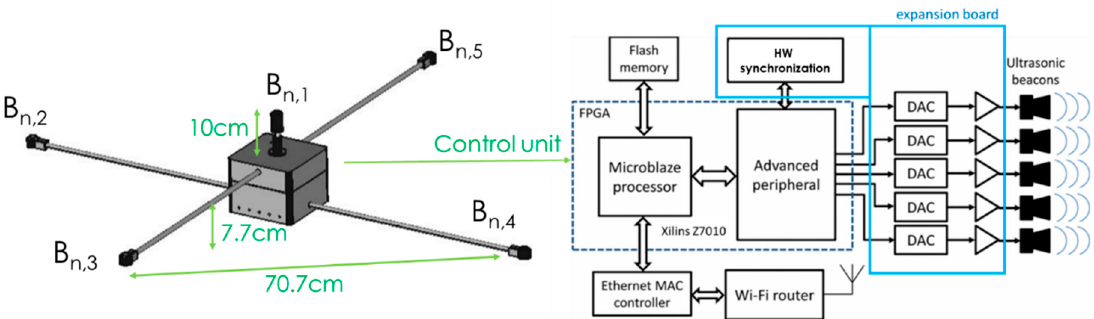
Figure 2. General description of the LOCATE-US beacon unit.